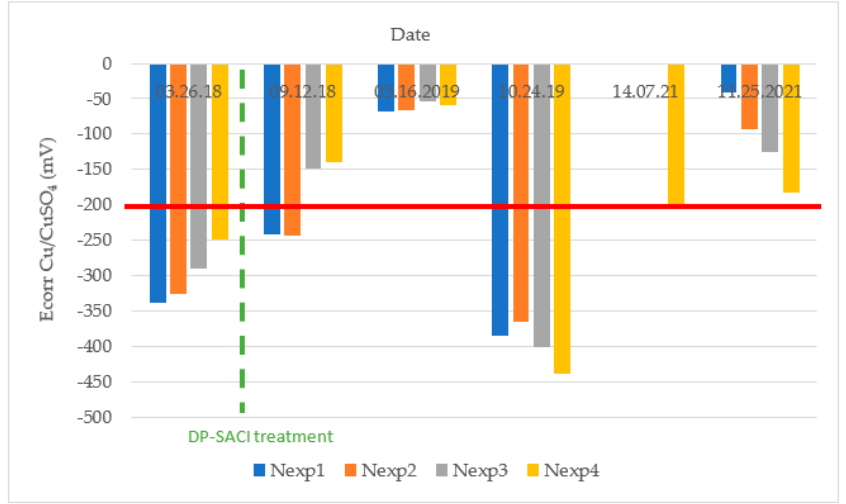
Figure 11. Ecorr evolution per ASTM C876 over the treated area at reference test points after DP-SACI treatment.